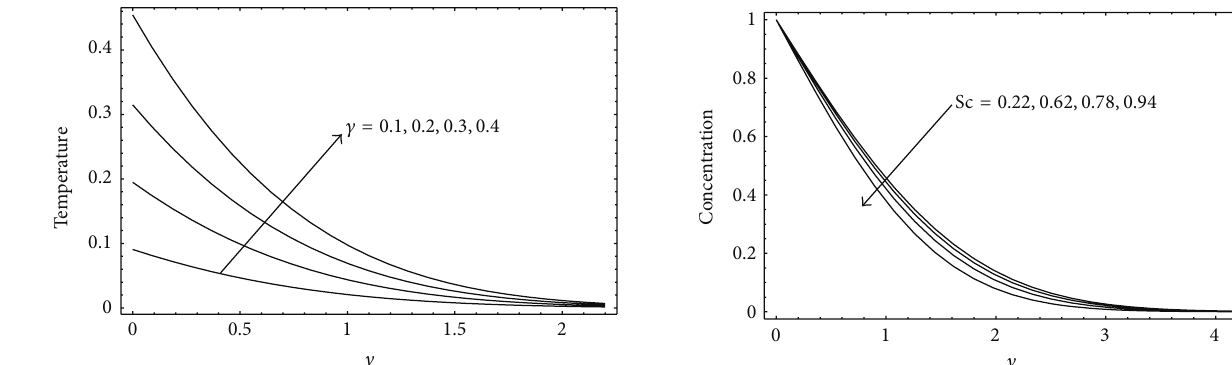
Figure 16: Concentration profiles for different values of Sc when 𝑡 = 0.2